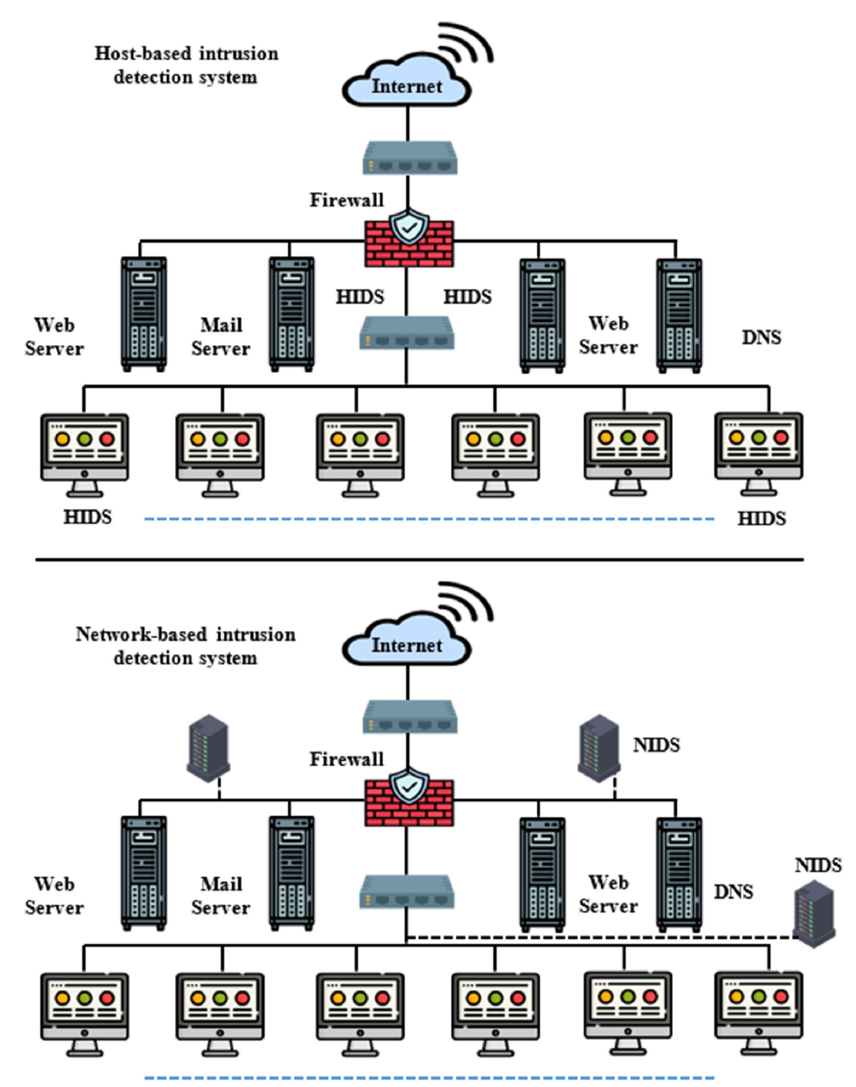
Figure 1. Comparison of the HIDS and NIDS structure [23].